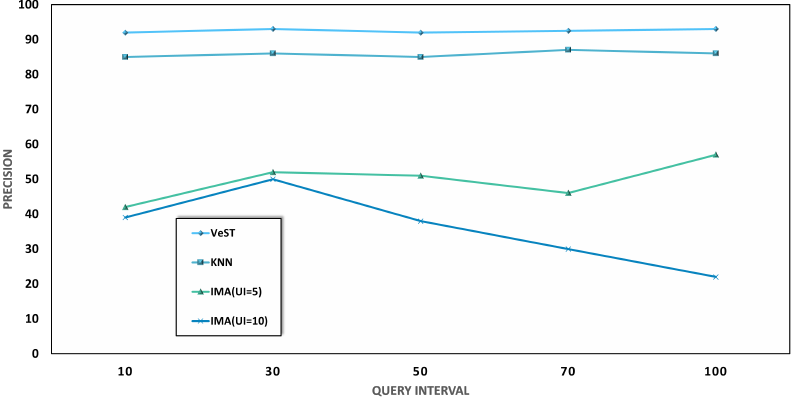
Figure 11. Effect of query interval length on